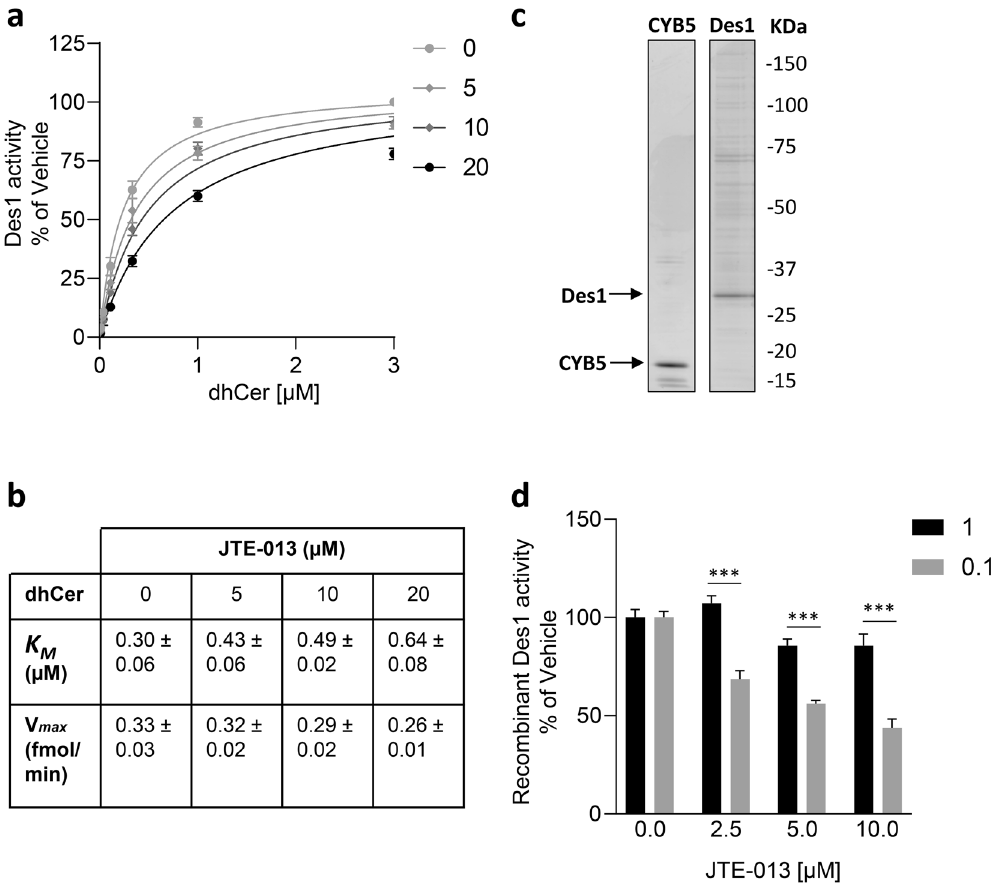
Figure 3. JTE-013 directly inhibits Des1 in a dihydroceramide-competitive manner. ( a ) Lysates from Des1- FLAG expressing HEK293T cells were assayed with varying doses of NBD-dhCer-C6 (3, 1, 0.3, 0.1, 0.03, 0.01 µM, solubilized in fatty acid-free BSA) and NADPH (1 mM final) with vehicle (DMSO, 0.7% final) or 5, 10 or 20 µM JTE-013 and production of NBD-Cer-C6 was quantified by HPLC. ( b ) Curve fitting analysis by non-linear regression was performed to determine the K M , V max and K i = 9.2 ± 0.8 µM. ( c ) Des1-FLAG was overexpressed in HEK293T cells for 24 h, purified using FLAG-agarose beads and eluted with FLAG peptide. Recombinant CYB5 (Sigma) and purified Des1-FLAG were separated by SDS-PAGE and detected by SYPRO- RUBY staining. Full SDS-PAGE gels are shown in Supplemental Fig. S3. ( d ) Purified Des1-FLAG was assayed using 1 µM (Black bars) or 0.1 µM (Grey bars) doses of NBD-dhCer-C6 (solubilized in fatty acid-free BSA) with vehicle (DMSO, 0.7% final) or 2.5, 5, or 10 µM JTE-013. Inhibition by JTE-013 was rescued by higher doses of dhCer indicating competitive mode of inhibition. All results are presented as percent of vehicle control; mean ± SEM (n = 3). Statistical significance was determined by Student’s t-test ( p value ***<